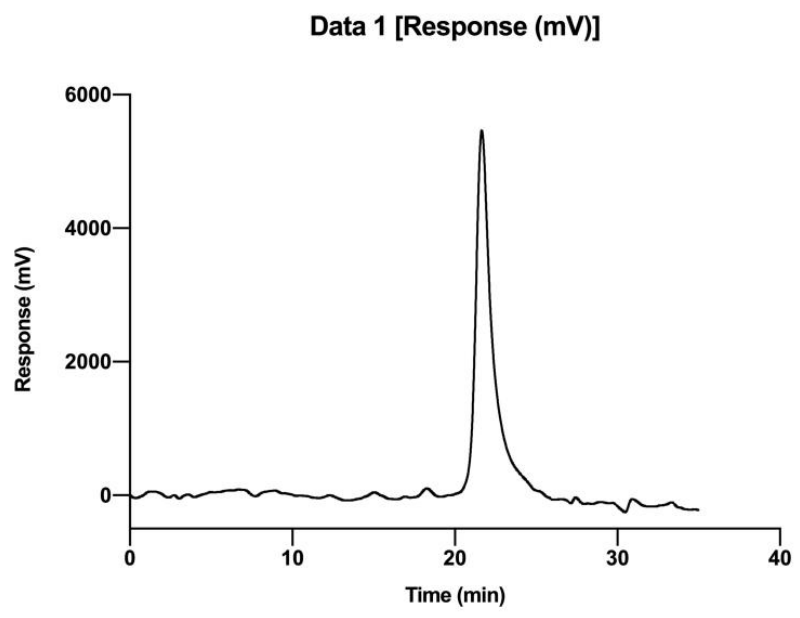
Figure 3. High-performance gel permeation chromatography (HPGPC) spectrum of PCP-1C.